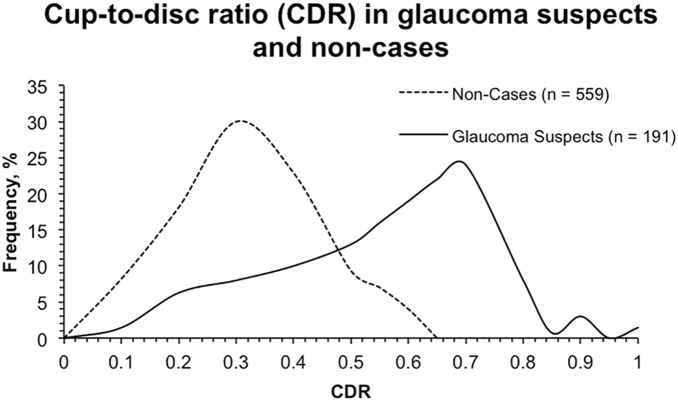
Frequency distribution curves for cup-to-disc ratio in non-cases and glaucoma suspects.